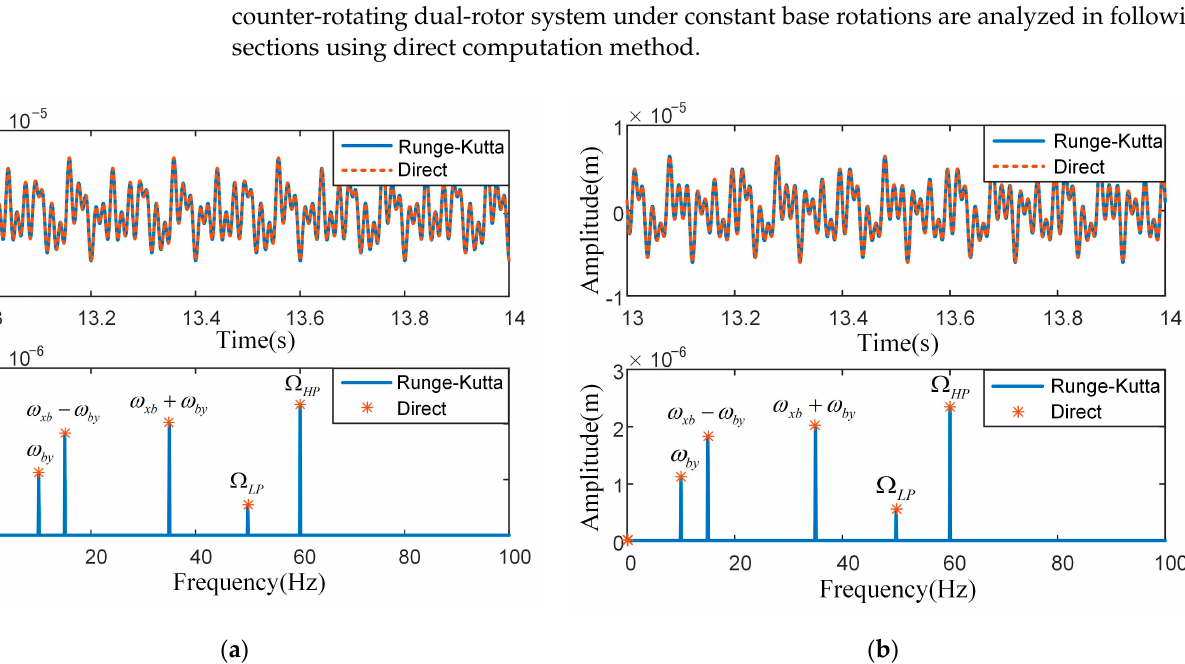
Figure 4. Comparison of the Runge–Kutta method and direct matrix operation: ( a ) Displacement x d 1 of the disk 1; ( b ) Displacement z d 1 of the disk